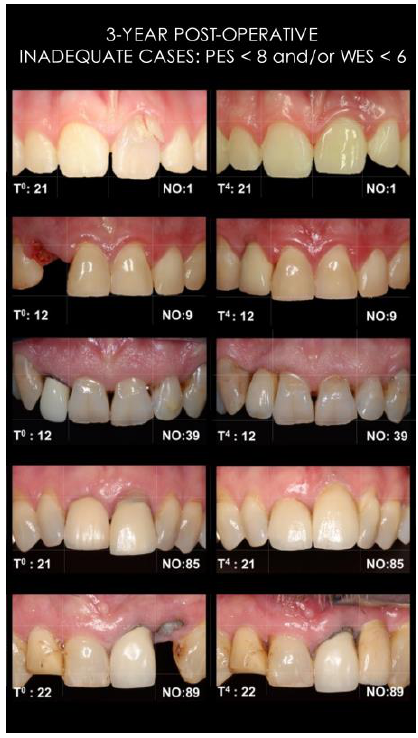
Figure 3. “Inadequate” esthetic outcomes at T4; no. 1 and 9 (WES = 5), no. 89 (PES = 3), no. 39 (PES = 7), and no. 85 (PES = 6). All patients were satisfied with the esthetic outcome (PS = 6.7, 9.8, 8.9, 9.6, and 9.3 for no. 1 to no. 89,